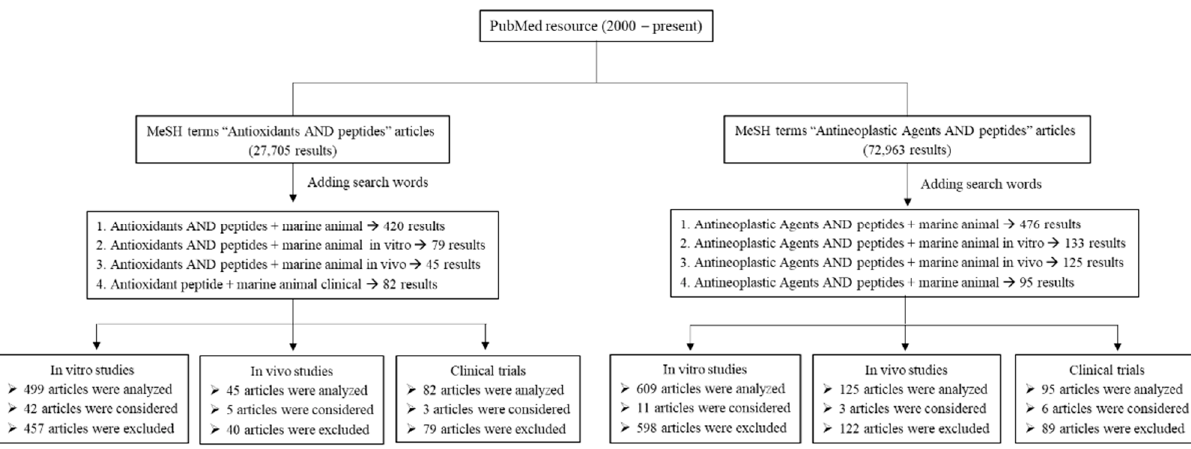
Figure 2. Schematic diagram of search strategy.